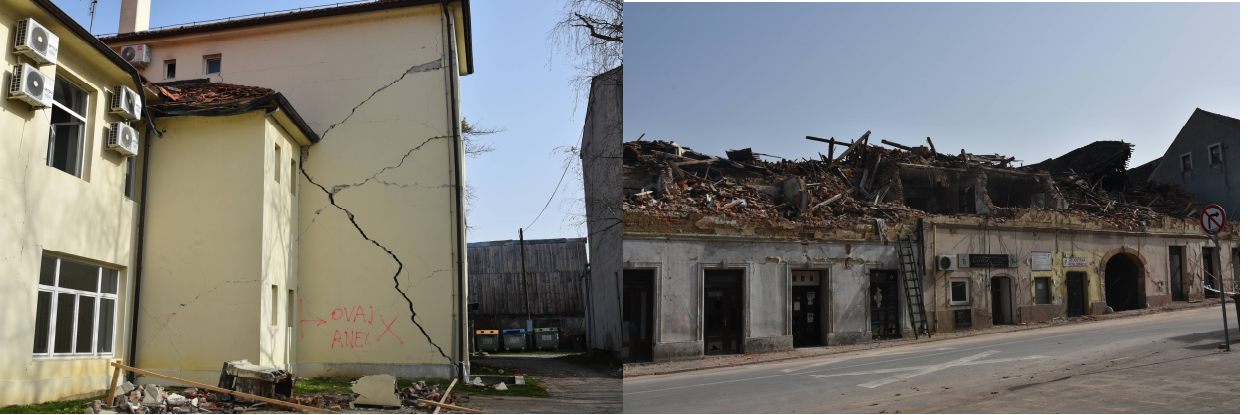
Figure 2. Damaged buildings in the historical center of Petrinja.